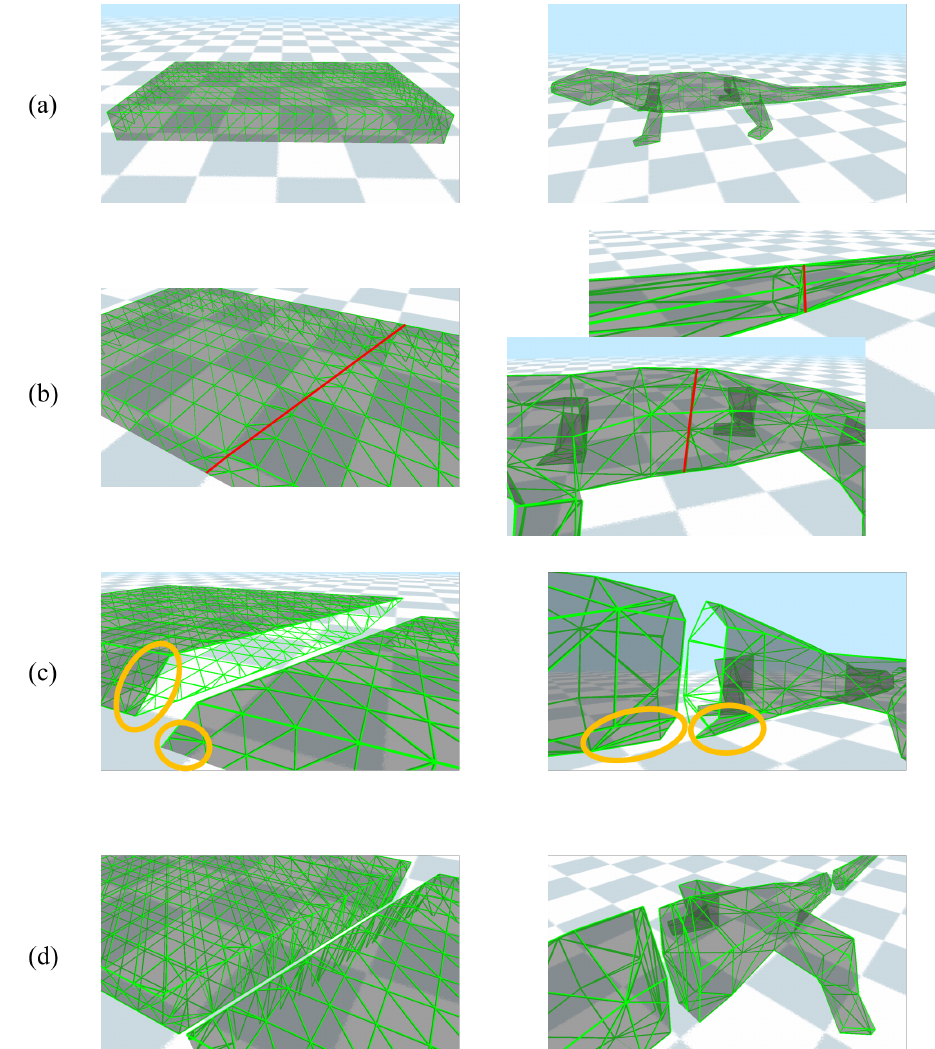
Figure 10. Topological deformation on a cuboid sponge model (left column) and an iguana model (right column): ( a ) original models, ( b ) mesh intersections (red lines), ( c ) deformed models without filling of the surface mesh (yellow circles), and ( d ) deformed models after filling the surface